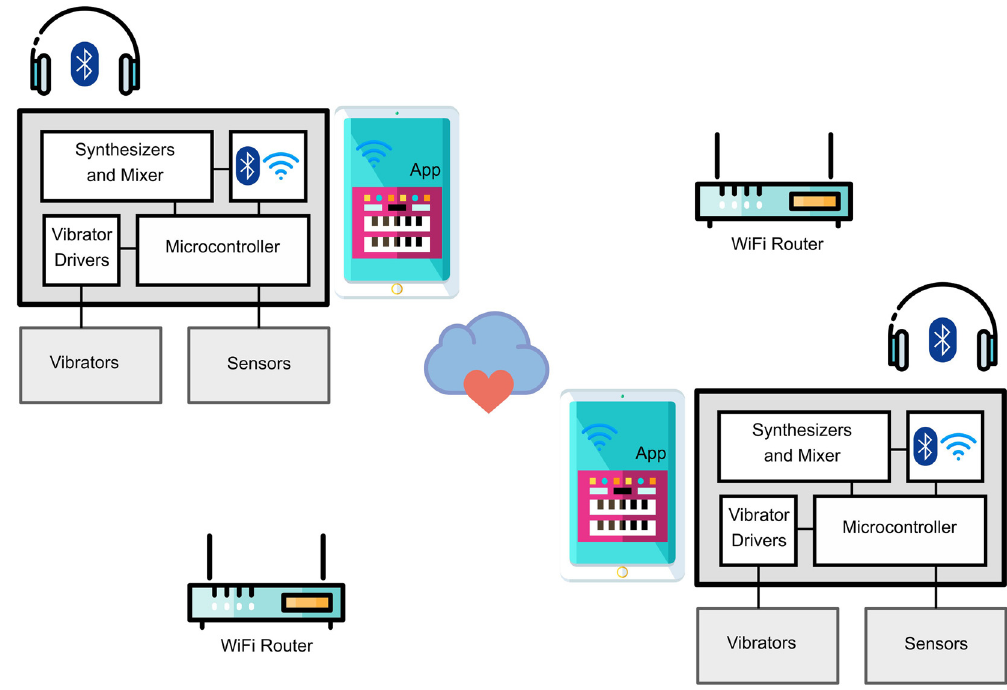
Figure 35: Planned practical solution of PLAY